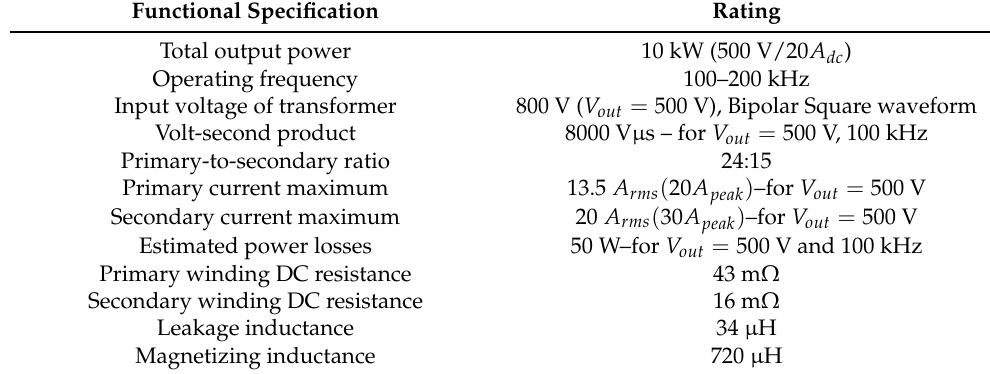
Table 2. Transformer